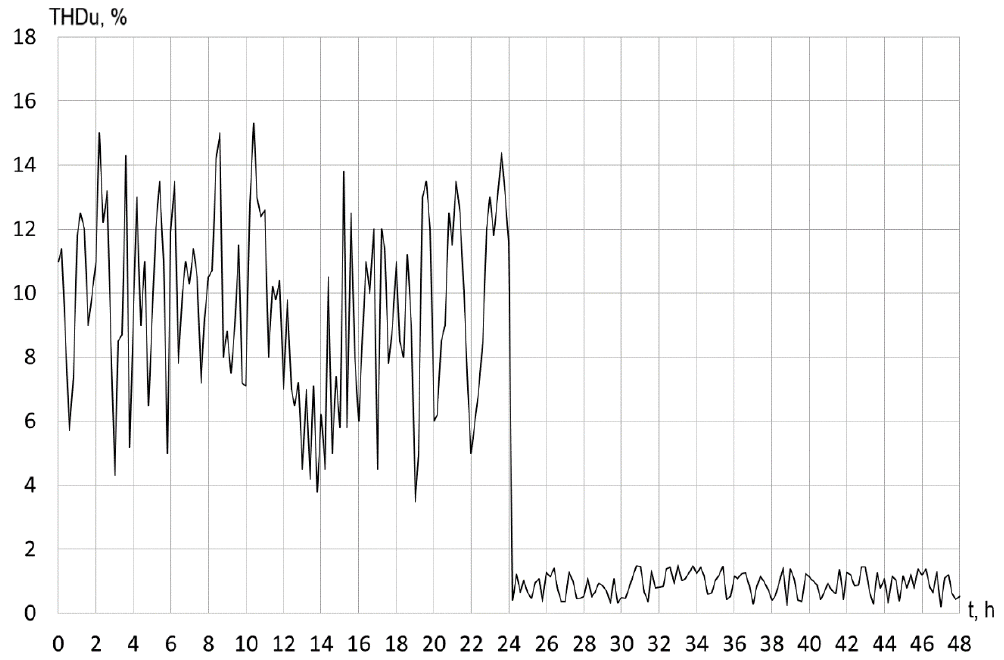
Figure 1. The voltage total harmonic distortion factor with a connected third-party powerful nonlinear load (0–24 h) and in its absence (24–48 h).